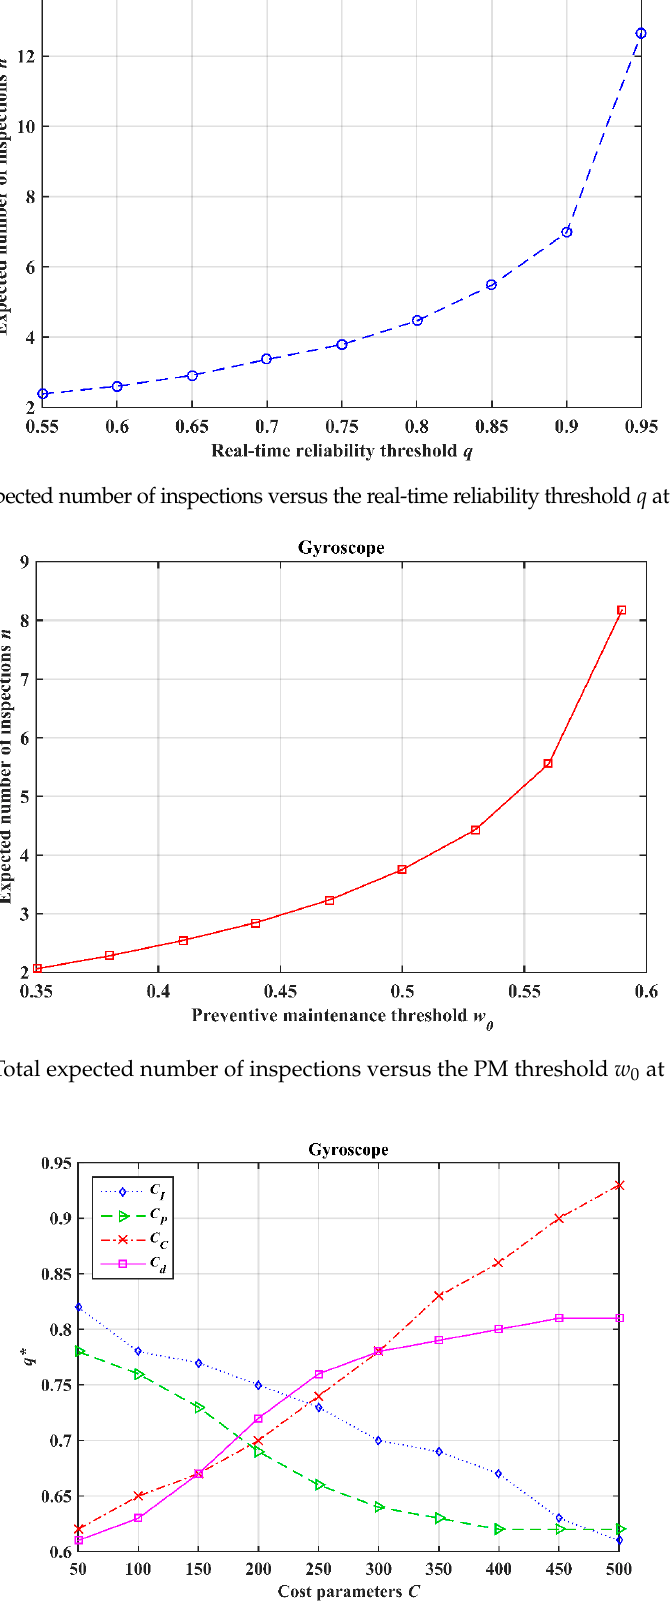
∗ . Figure 8. Influence of the cost parameters on the optimal value q ∗